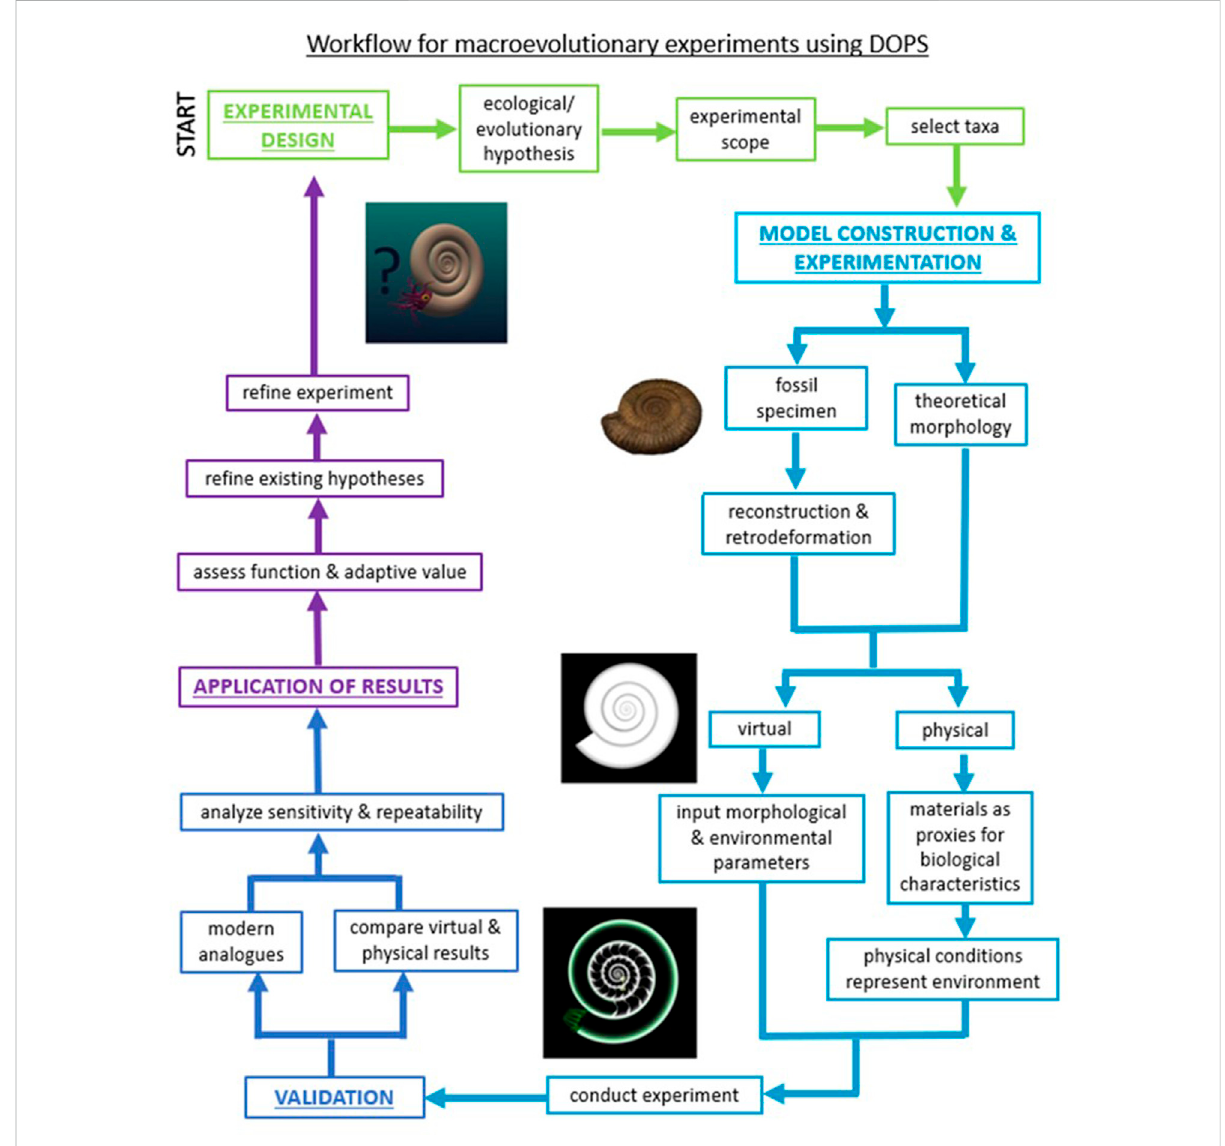
FIGURE 1 Generalized work fl ow for using DOPs to study macroevolutionary hypotheses showing steps to experimental design, model construction, experimentation, validation, and application of results. Thework fl owisiterative bydesign,allowing formodelsandexperiments tobere fi nedas new results are